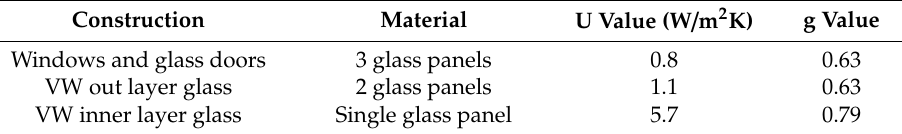
Table 3. Window constituents and properties.